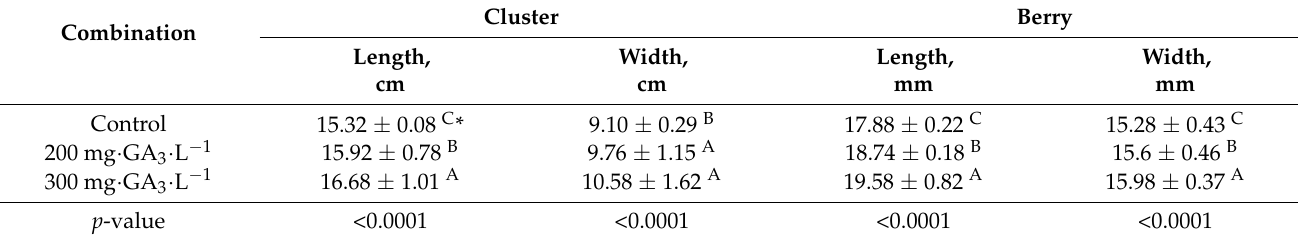
Table 2. Effect of gibberellic acid on the quality of yield of ‘Einset Seedless’ grapevine